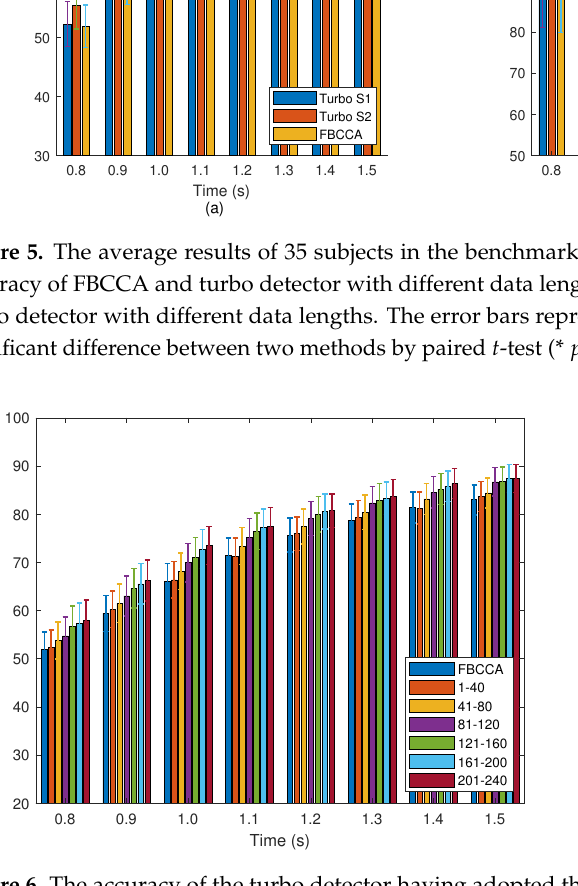
Figure 6. The accuracy of the turbo detector having adopted the S2 data selection strategy with 0.8 and 1.5 s data length. The error bars represent the standard